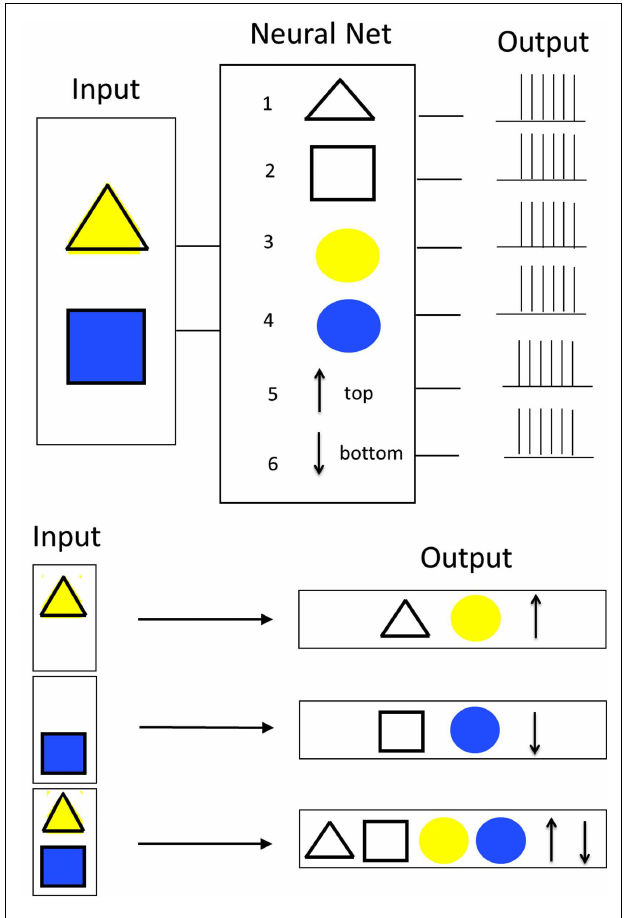
FIGURE 1 | Classical illustration of the binding